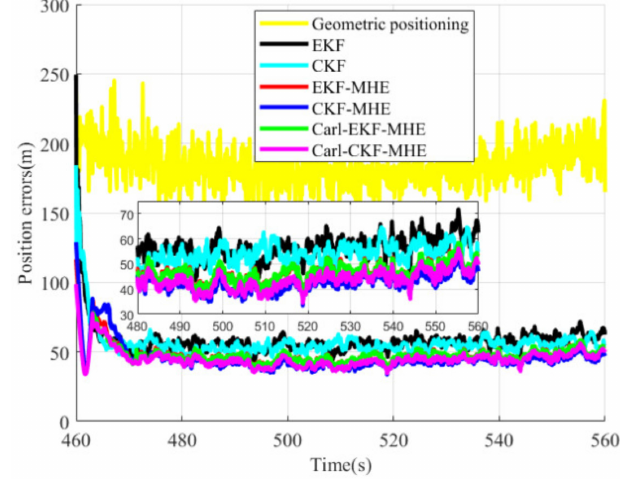
Figure 8. Position estimation errors.